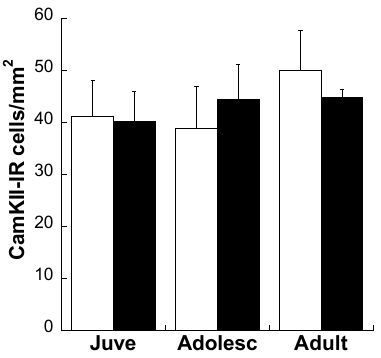
( t (10) = 2.38; p = 0.04). Effects of MS on D2R endured into adulthood, as MS adults also displayed lower D2R expression on CamKIIa-IR cells ( t (8) = 5.75; p < 0.001). Figure 2. Density of CamKIIa-immunoreactive (IR) cells per mm 2 in the plPFC of CON (white bars) and MS (black bars) rats at three ages. Averages ± SEM are represented.